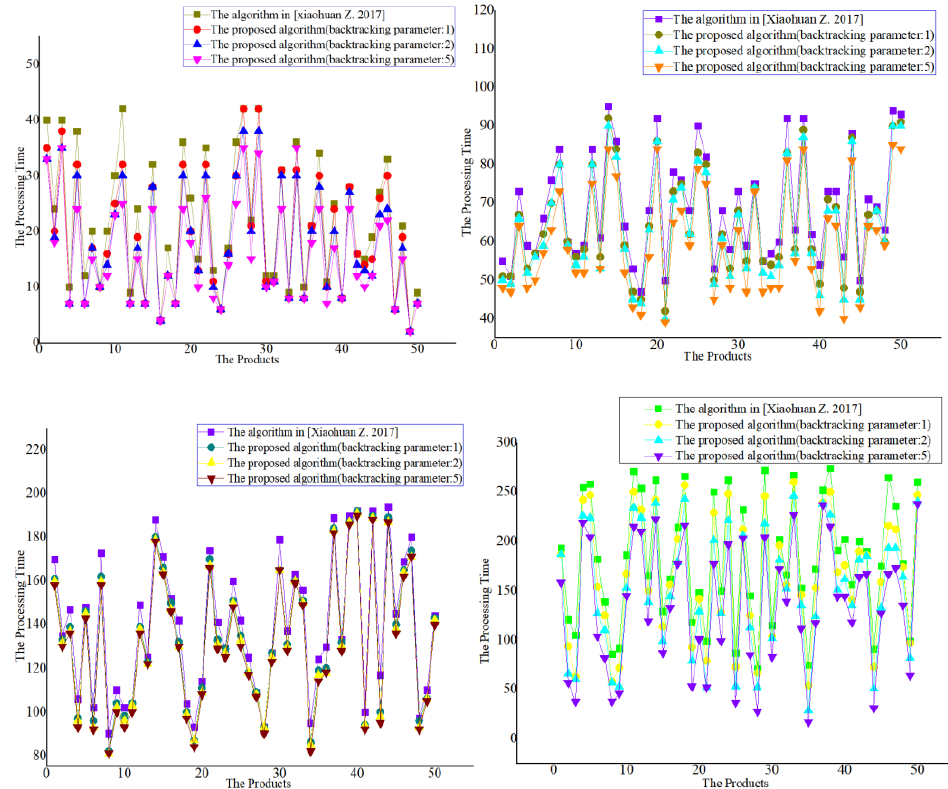
Figure 13. Comparison between the proposed algorithm and Ref. [17].